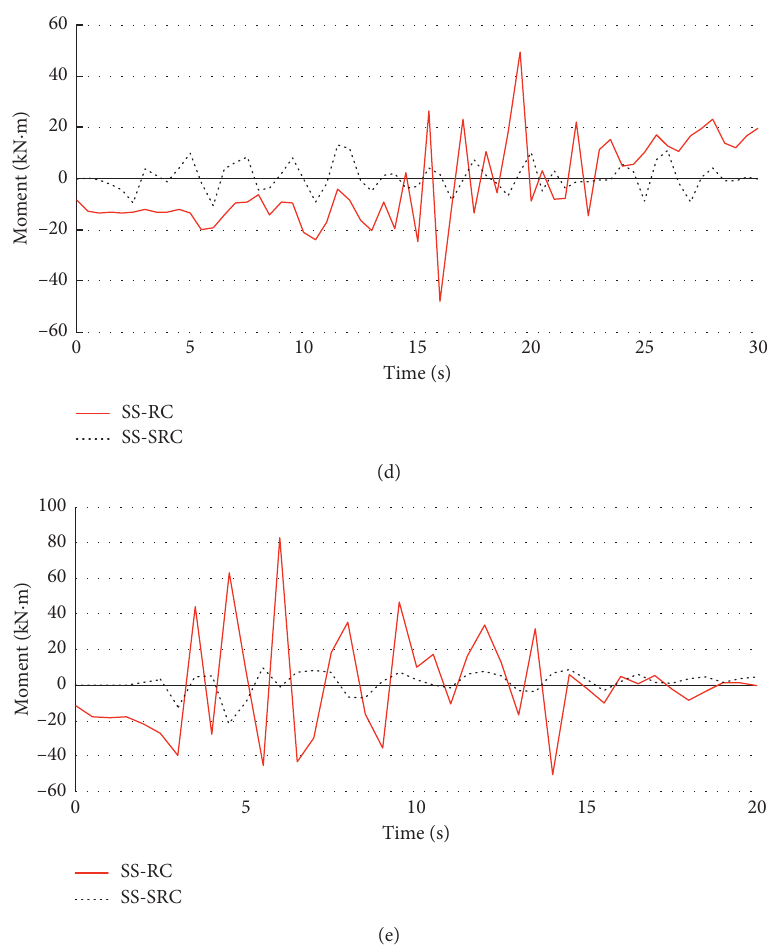
Figure 21: Time histories of maximum moments of the RC column bottoms. (a) Tohoku, (b) Mammoth Lakes. (c) Chi-Chi, (d) El Centro, and (e)